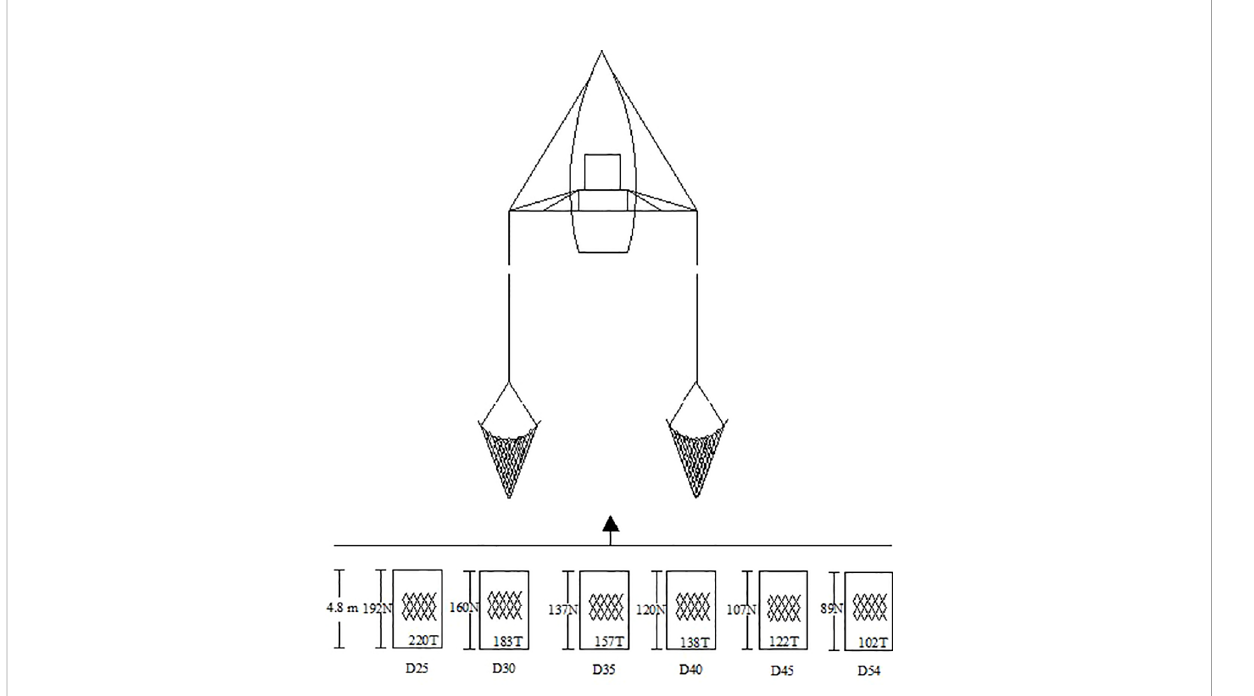
FIGURE 2 Schematic view of the experimental setup tested in the